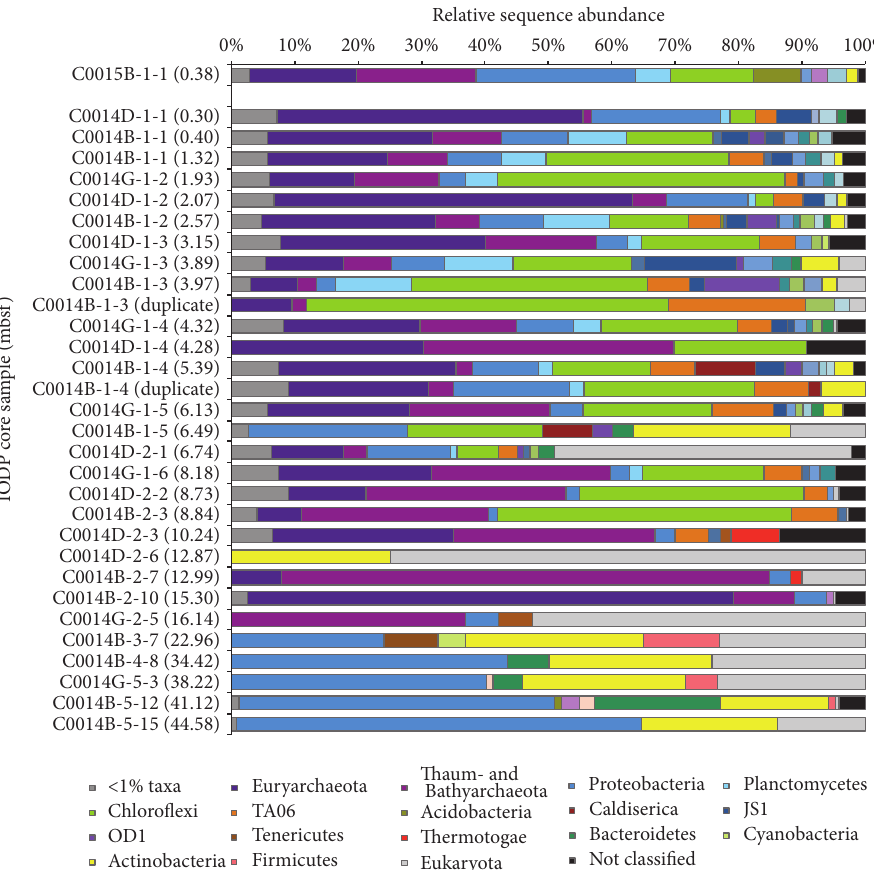
Figure 2: Relative sequence abundance, listed as % across the 𝑥 -axis, of 16S rRNA gene amplicons from Site C0014 sediment samples classified atthephylumlevel.Samplehorizonsarelistedbyincreasingdepthbelowseafloor.IODPsamplenamesarelistedalongthe 𝑦 -axisbyincreasing depth (meters) below seafloor, depth in parentheses. Site C0015, 600 m northwest and upslope of the hydrothermal vent (shown separately as the topmost sample), showed no current hydrothermal activity and is being compared to represent nonhydrothermal conditions within the Iheya North Field. Sequences included here are those identified as likely to represent indigenous taxa in Figure 1. See Table S1 for additional sequence